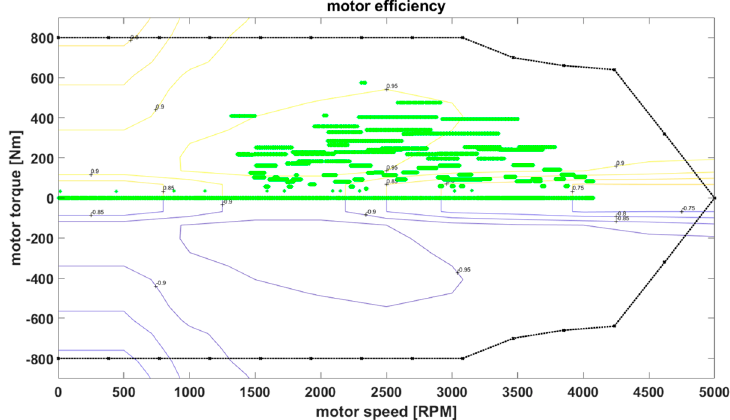
Figure 12. E ffi ciency points of the HEHV (rule-based) electric Figure 12. Efficiency points of the HEHV (rule-based) electric motor.